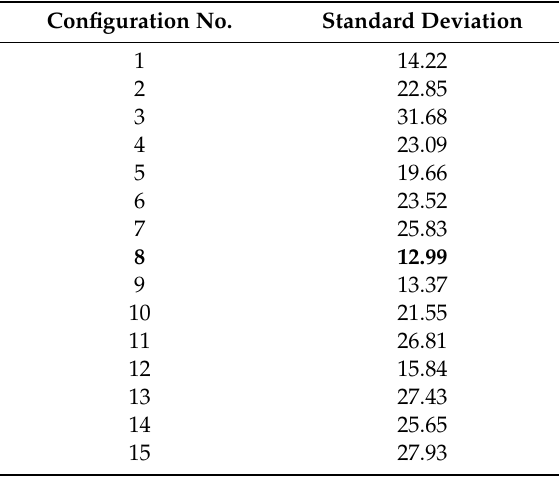
Table 1. Standard deviation of homogenous sensitivity for di ff erent sensor configurations.